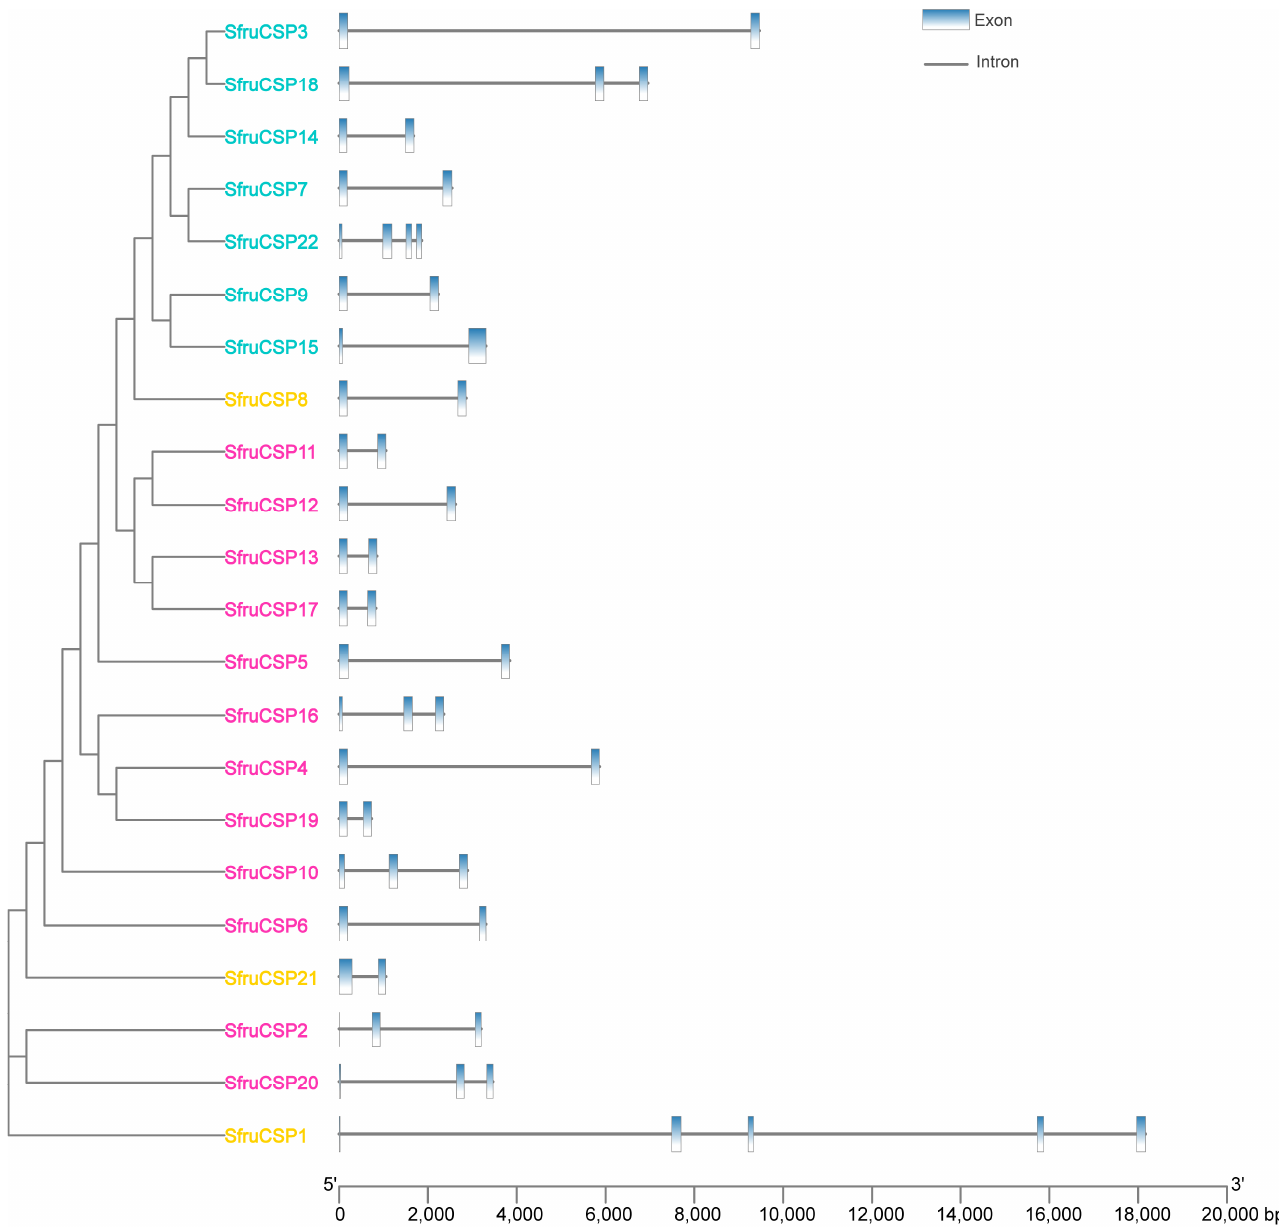
Figure 6. Exon–intron structures of SfruCSP genes. The blue boxes represent exons and the black lines indicate introns. The x ‐ axis below scales the nucleotide sequence length (bp) of the gene. The full ‐ length intron/exon composition of each gene is reported in Table 2. Different colors of the gene names indicate CSPs from specific clusters as indicated in Figure 2: orange, Cluster 1; pink, Cluster 2; bright green, Cluster 3; cyan, Cluster 4.